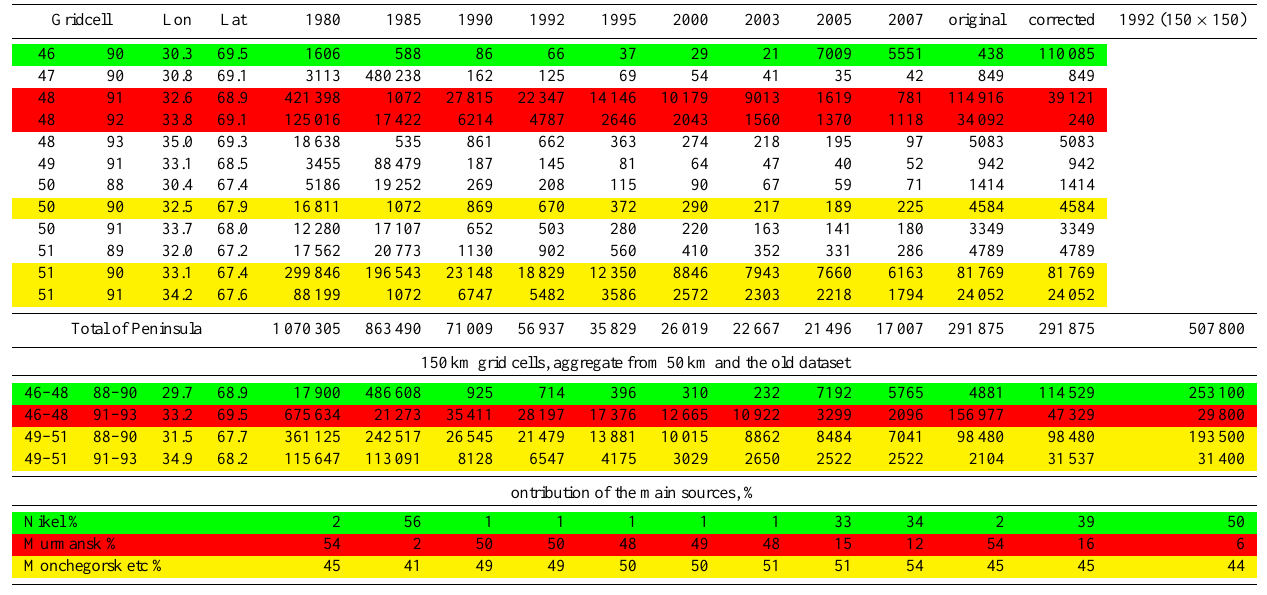
Table 1. The EMEP SO x emission data for Kola Peninsula. (Unit: tons of SO 2 per grid cell per year.)